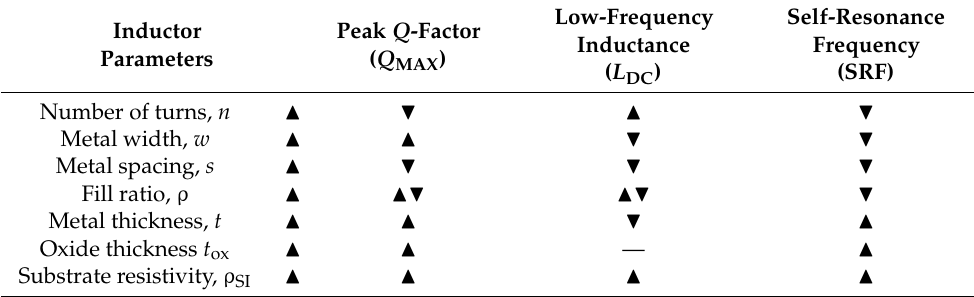
Table 1. Layout/process parameters vs. electrical performance of an integrated inductor.